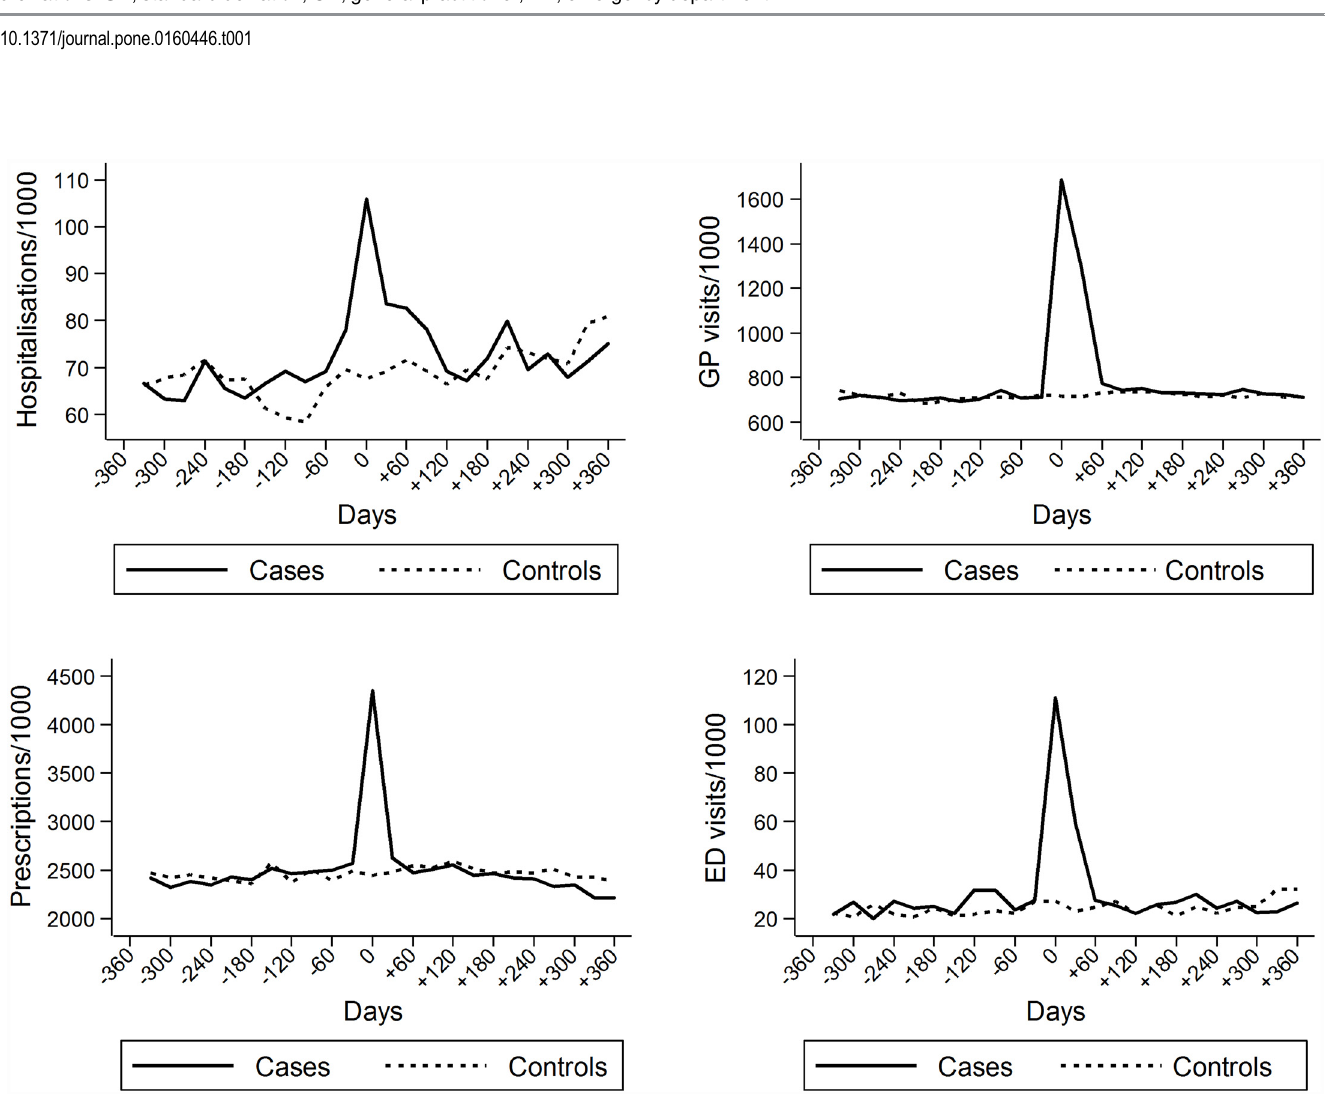
Fig 1. Healthcare resource usage in herpes zoster cases and controls per 1000 population in relation to time at diagnosis or index day (day = 0). Note: ED, emergency department, GP, general practitioner.